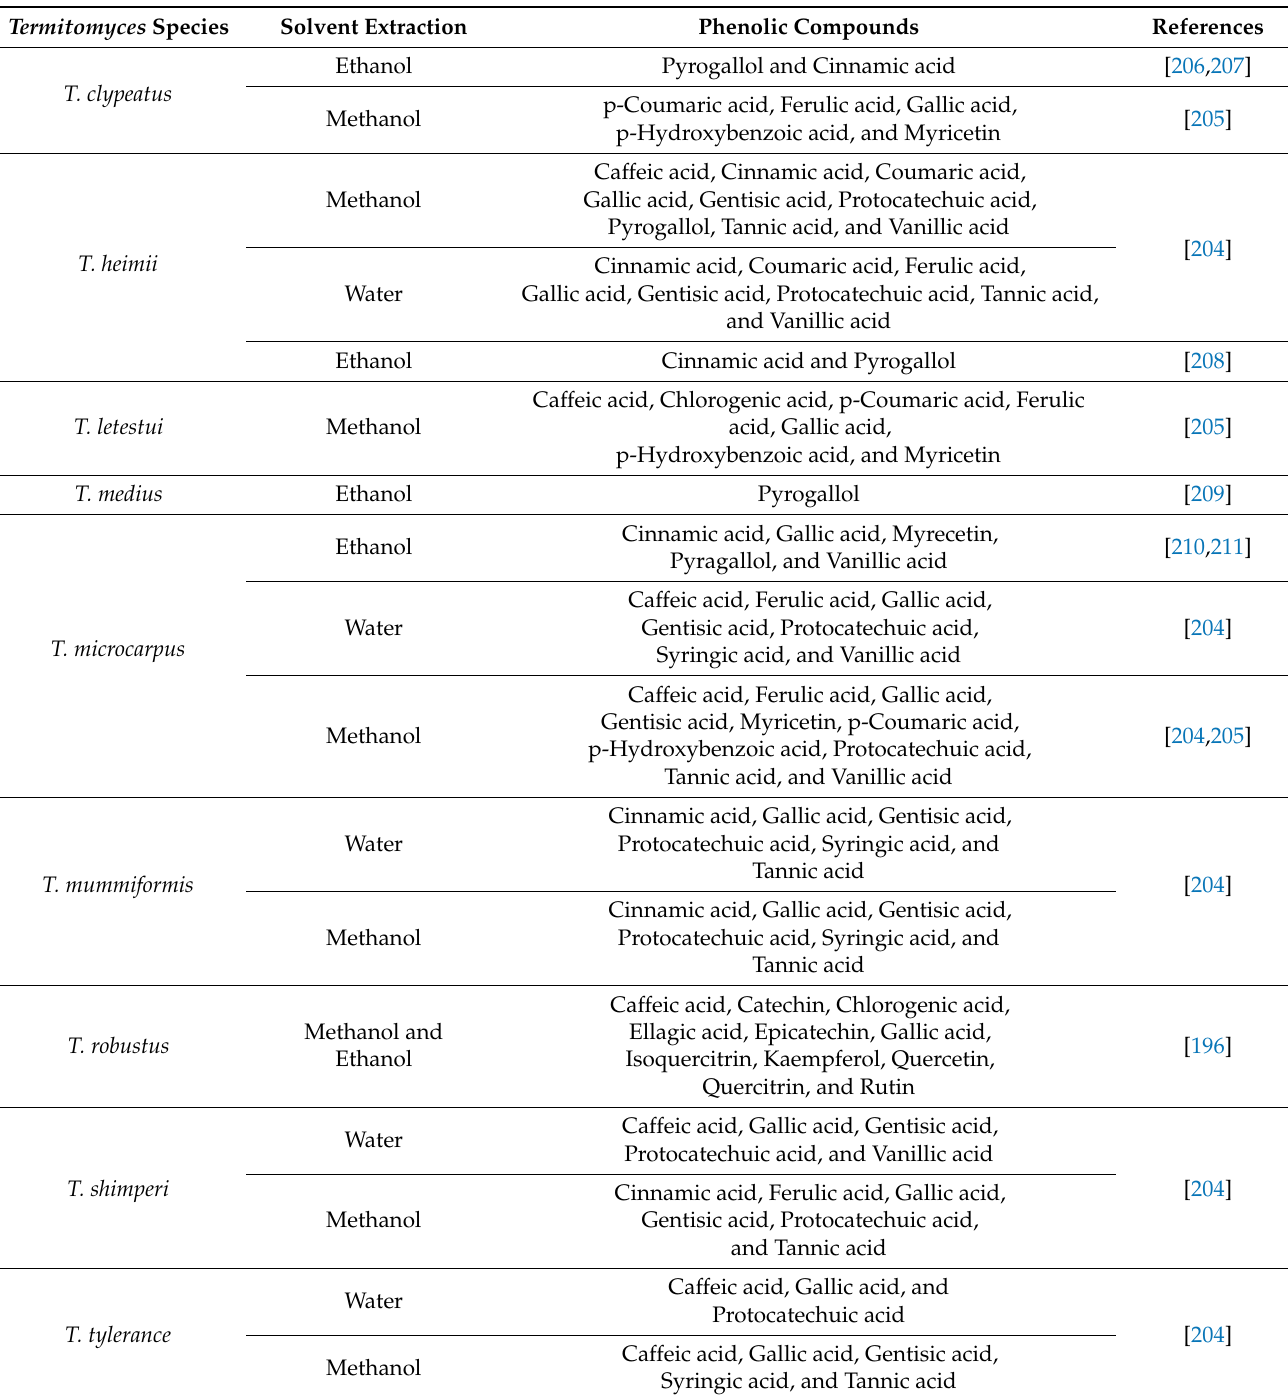
Table 4. Phenolic compounds present in different extracts of Termitomyces